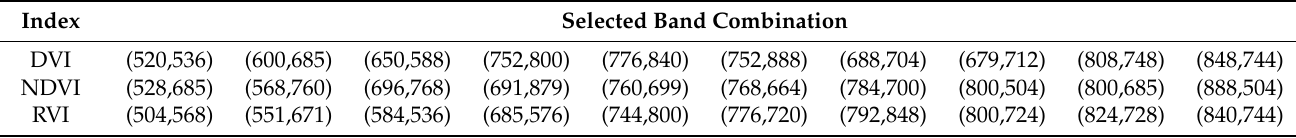
Table 4. Selected vegetation indices and their corresponding